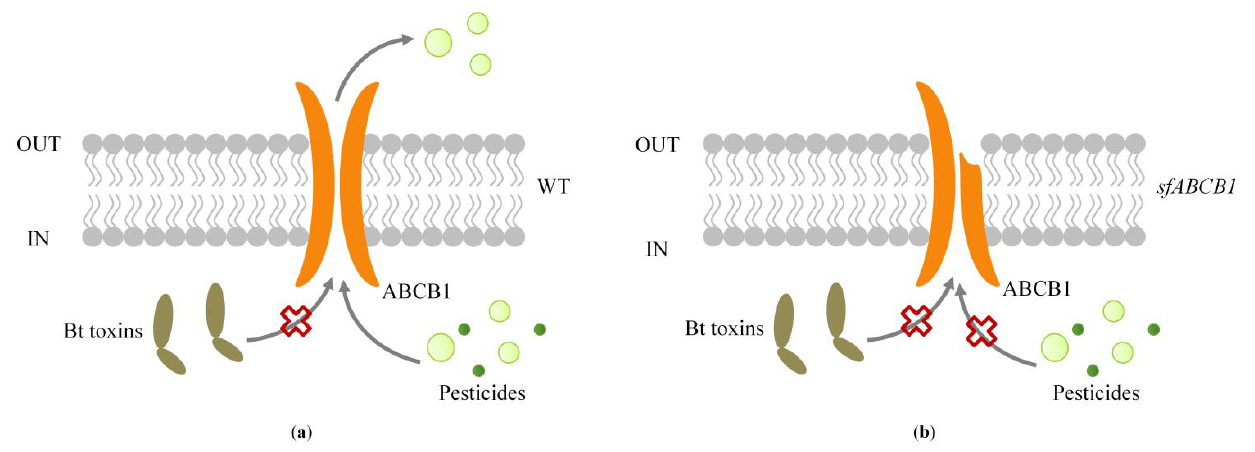
Figure 4. Model to explain the role of ABCB1 in Spodoptera frugiperda in increasing susceptibility to emamectin benzoate, beta-cypermethrin, and chlorantraniliprole in vivo. ( a ) Model of ABCB1 in wild type DH19strain (WT). ABCB1 can transport some pesticides extracellular, but not Bt; ( b ) Model of ABCB1 in knockout strain ( sfABCB1 ). The deformed ABCB1 protein cannot perform normal transportation functions, resulting in cellular toxins accumulation.